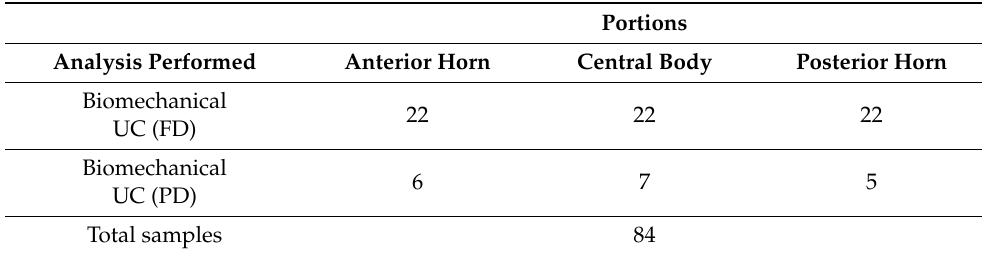
Figure 1. Sample preparation. Cylindrical and rectangular samples from the posterior (P), central (C), and anterior (A) regions were obtained for compression and tension tests, respectively. Stripes were obtained along the radial and circumferential directions. Table 2. The number of each sample utilized for biomechanical unconfined compression (UC) test. FD: fully developed; PD: partially